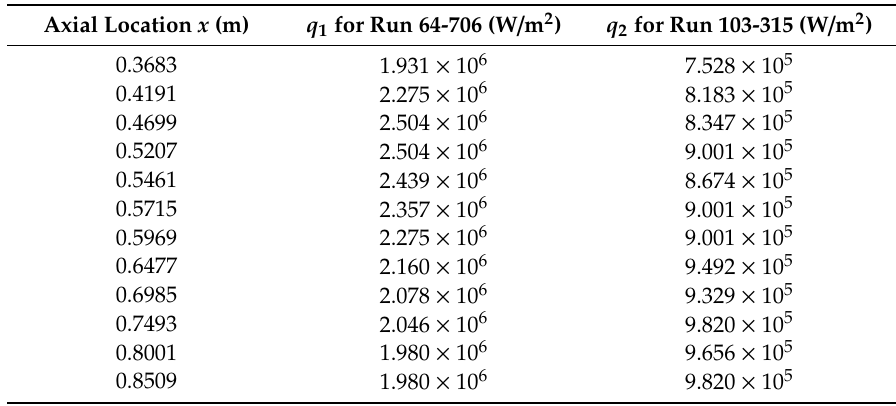
Table A1. Main parameters of two experimental conditions, Run 64-706 and Run 103-315. Conditions No. Table A2. Measured heat flux on the tube wall for Run 64-706 and Run 103-315.